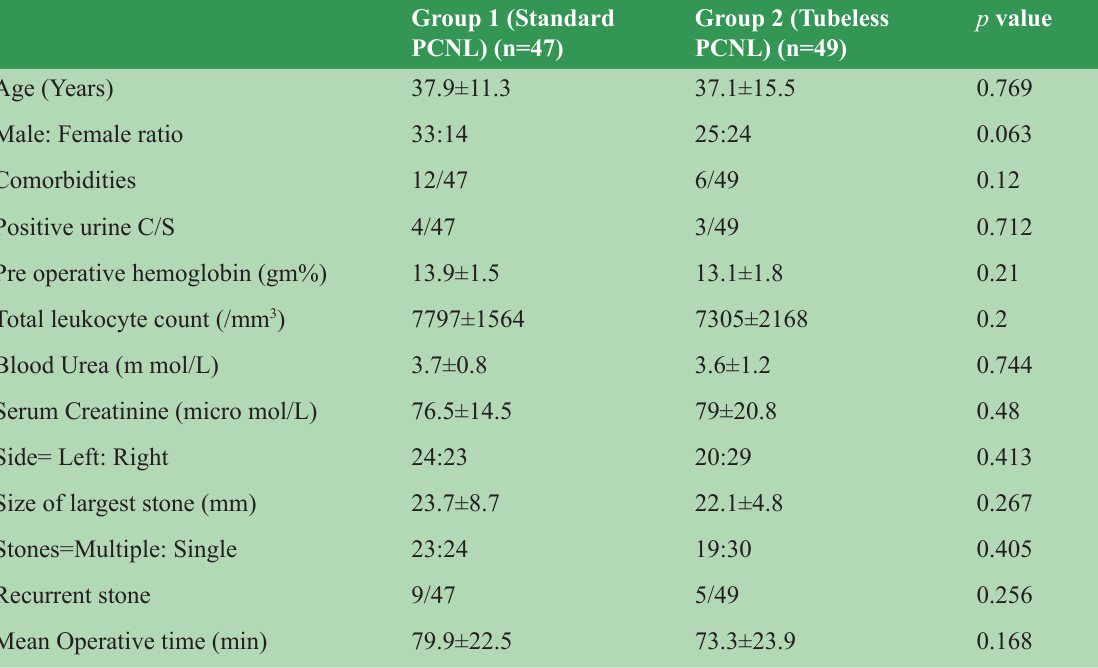
Table 1: Patient characteristics